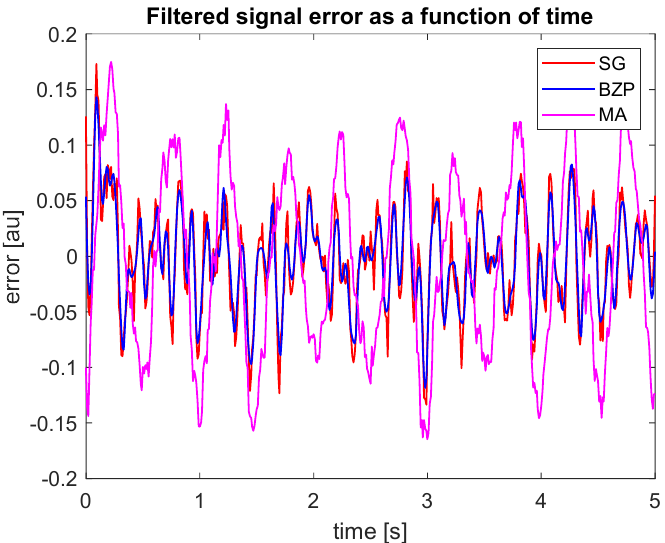
Figure 4. Point by point error as difference between each processed signal and the analytical reference. Table 4. Performance indicators for low pass filtering of noisy 2 and 5 Hz time signals.